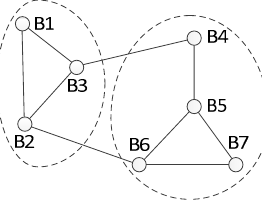
Figure 3. The system with seven substations in two regions, which can be used to explain partition correction under an N-1 channel